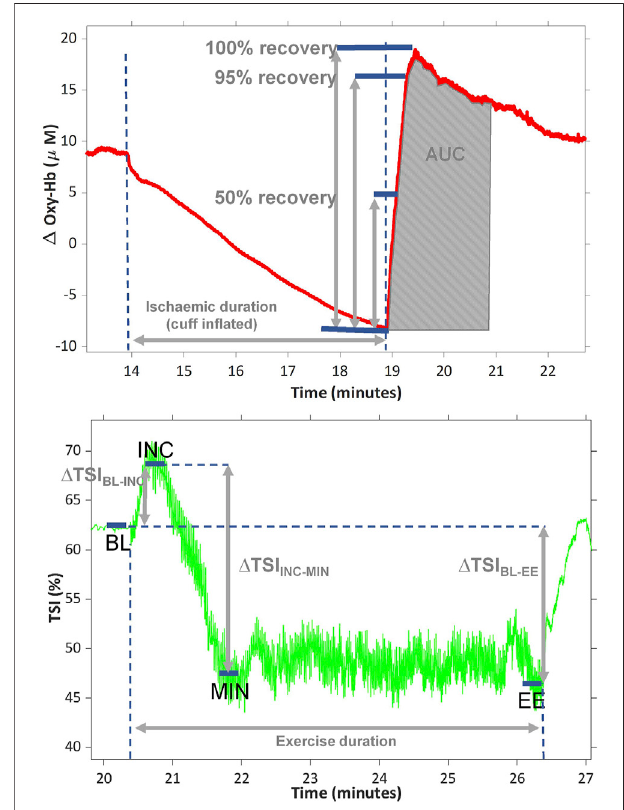
FIGURE 1 | representative traces showing the change in oxygenated haemoglobin (oxy-Hb) during ischaemia and post occlusive reactive hyperaemia (PORH) (top) and change in tissue saturation index (TSI%) during exercise (bottom). Area under the curve (AUC) was calculated after normalising the start of PORH to zero. TSI was averaged over 5 s at baseline (BL), at the peak of the initial increment at onset of exercise (INC), at the minimum observed during exercise (MIN) and at the end of exercise (EE). Δ TSI Δ TSI BL-INC is the difference between TSI at BL and INC; BL-EE is the TSI change from BL-EE; Δ TSI INC-MIN is the TSI change from INC to MIN. All values are presented as positive values, despite Δ TSI BL-EE being a negative